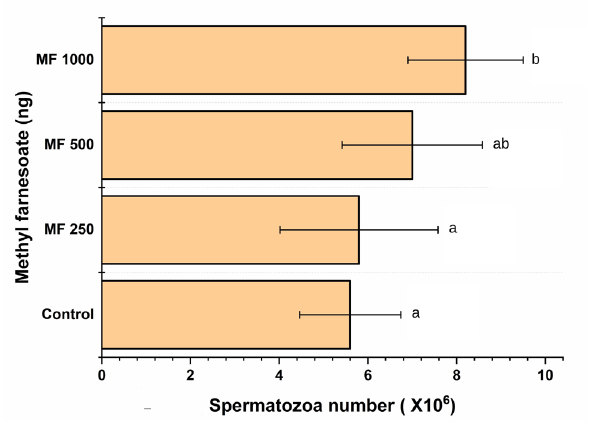
Figure 5. Effect of different dosages of MF on spermatozoal number (x 10 6 ) in male Pontastacus leptodactylus . Letters indicate significant difference groupings ( P < 0.05) (mean ± S.D; n =